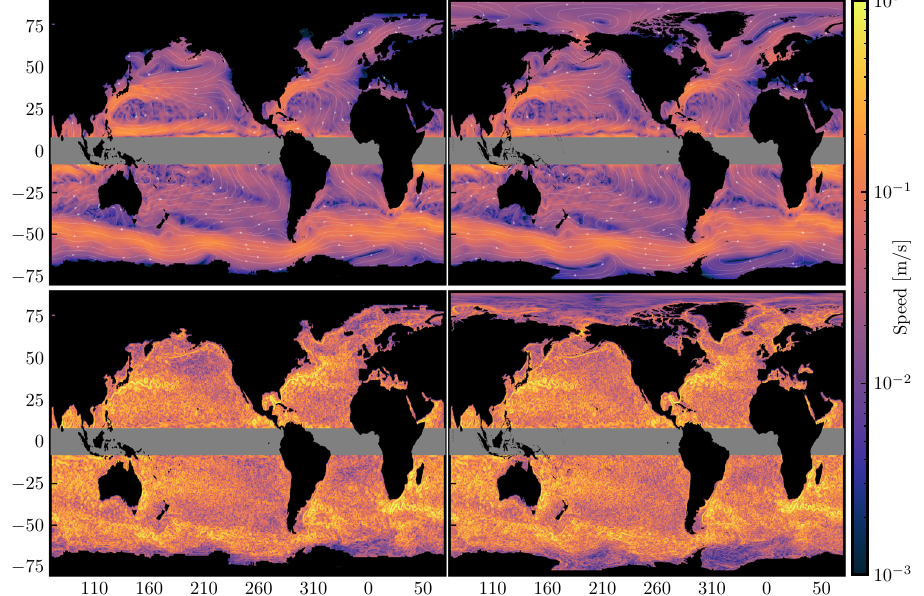
Fig. 1 | Gyre-scale and mesoscale fl ows. Colour maps show the geostrophic velocity magnitude for length scales [top] larger than 10 3 km and [bottom] smaller than 10 3 km for a single day (02 Jan 2015). [Left] shows the 1/4° AVISO dataset and [right] the 1/12° NEMO dataset. [White lines] highlight the corresponding